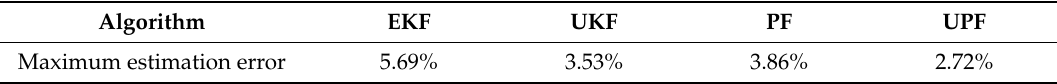
Figure 15. Estimation error curves of different algorithms at −10 °C.